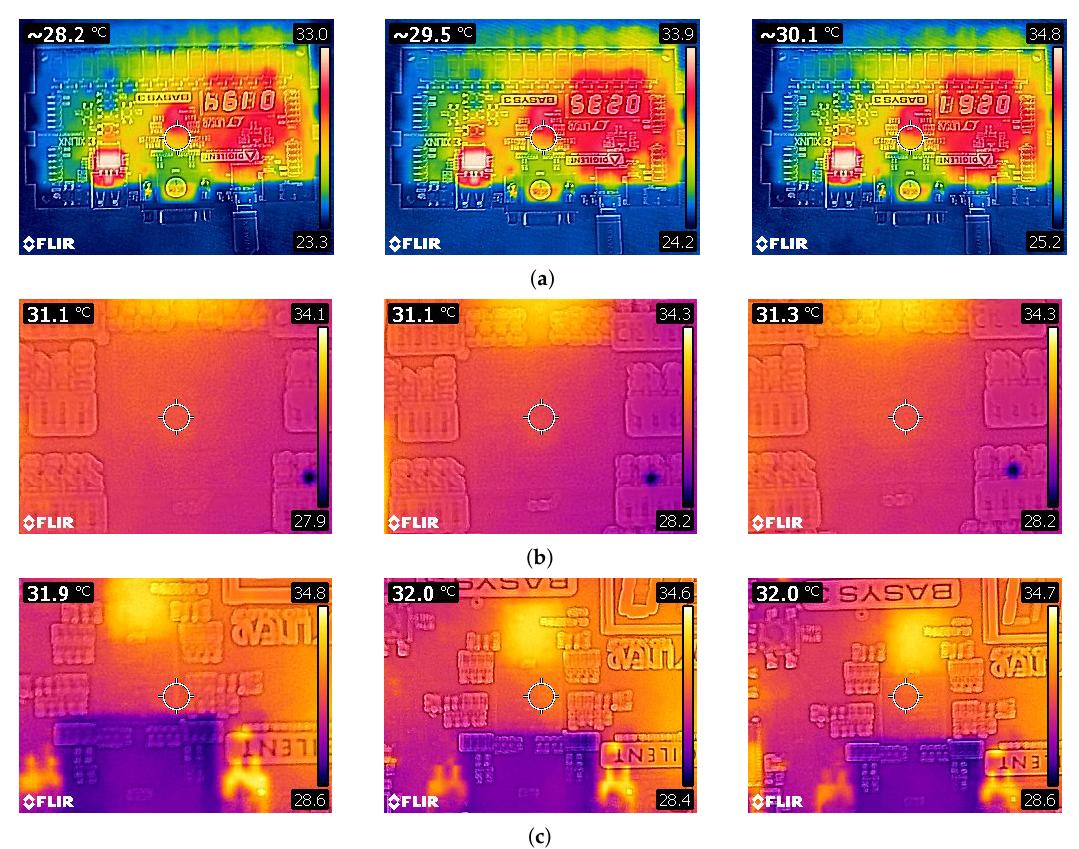
Figure 14. The set of Figure ( a ) from right to left represents the readings for the trojan free, sleeping and active respectively. The set of Figure ( b ) demonstrate a close up representation of the trojan free, sleeping and active on the board, while the set of Figure ( c ) provide close up temperature readings of the trojan active on the board over a period of 10 min.